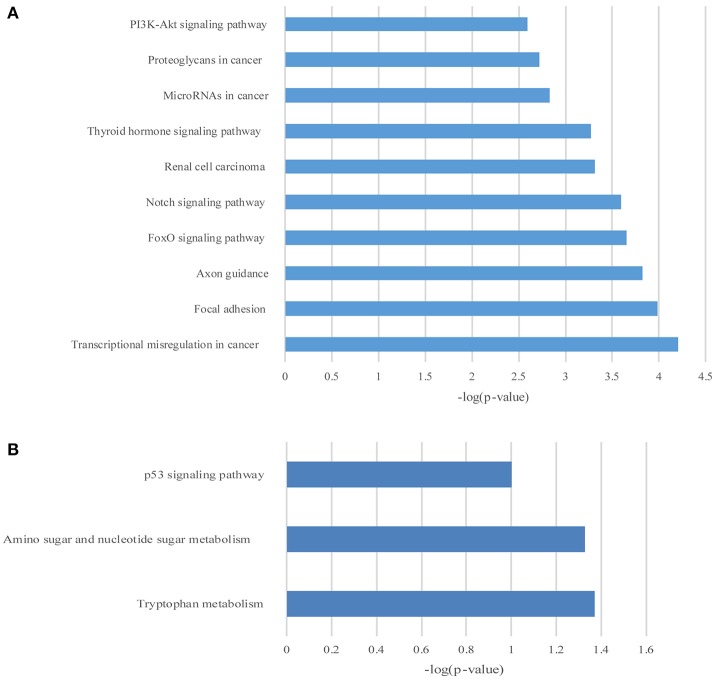
The KEGG pathway enrichment analysis on differentially expressed mRNAs. The top 10 enrichment scores in the KEGG pathway analysis of the up-regulated mRNAs (A) and top 3 down-regulated mRNAs (B).